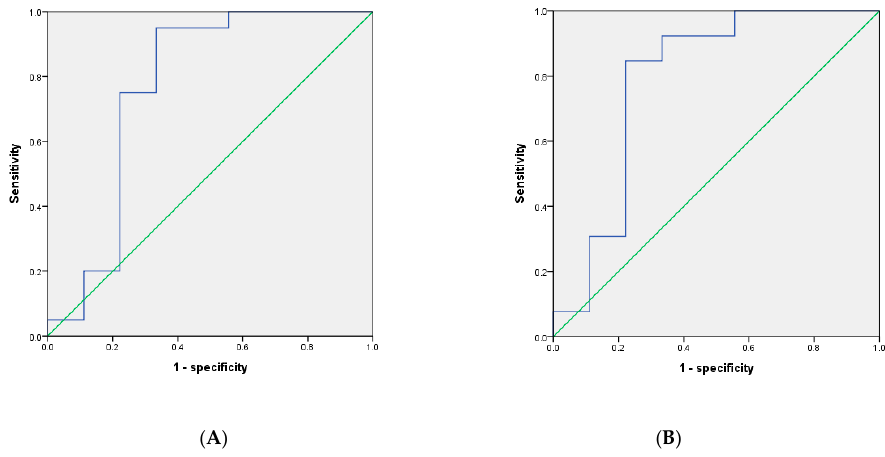
Figure 2. Comparative TRODAT ratio between the control and ESRD with RLS groups.